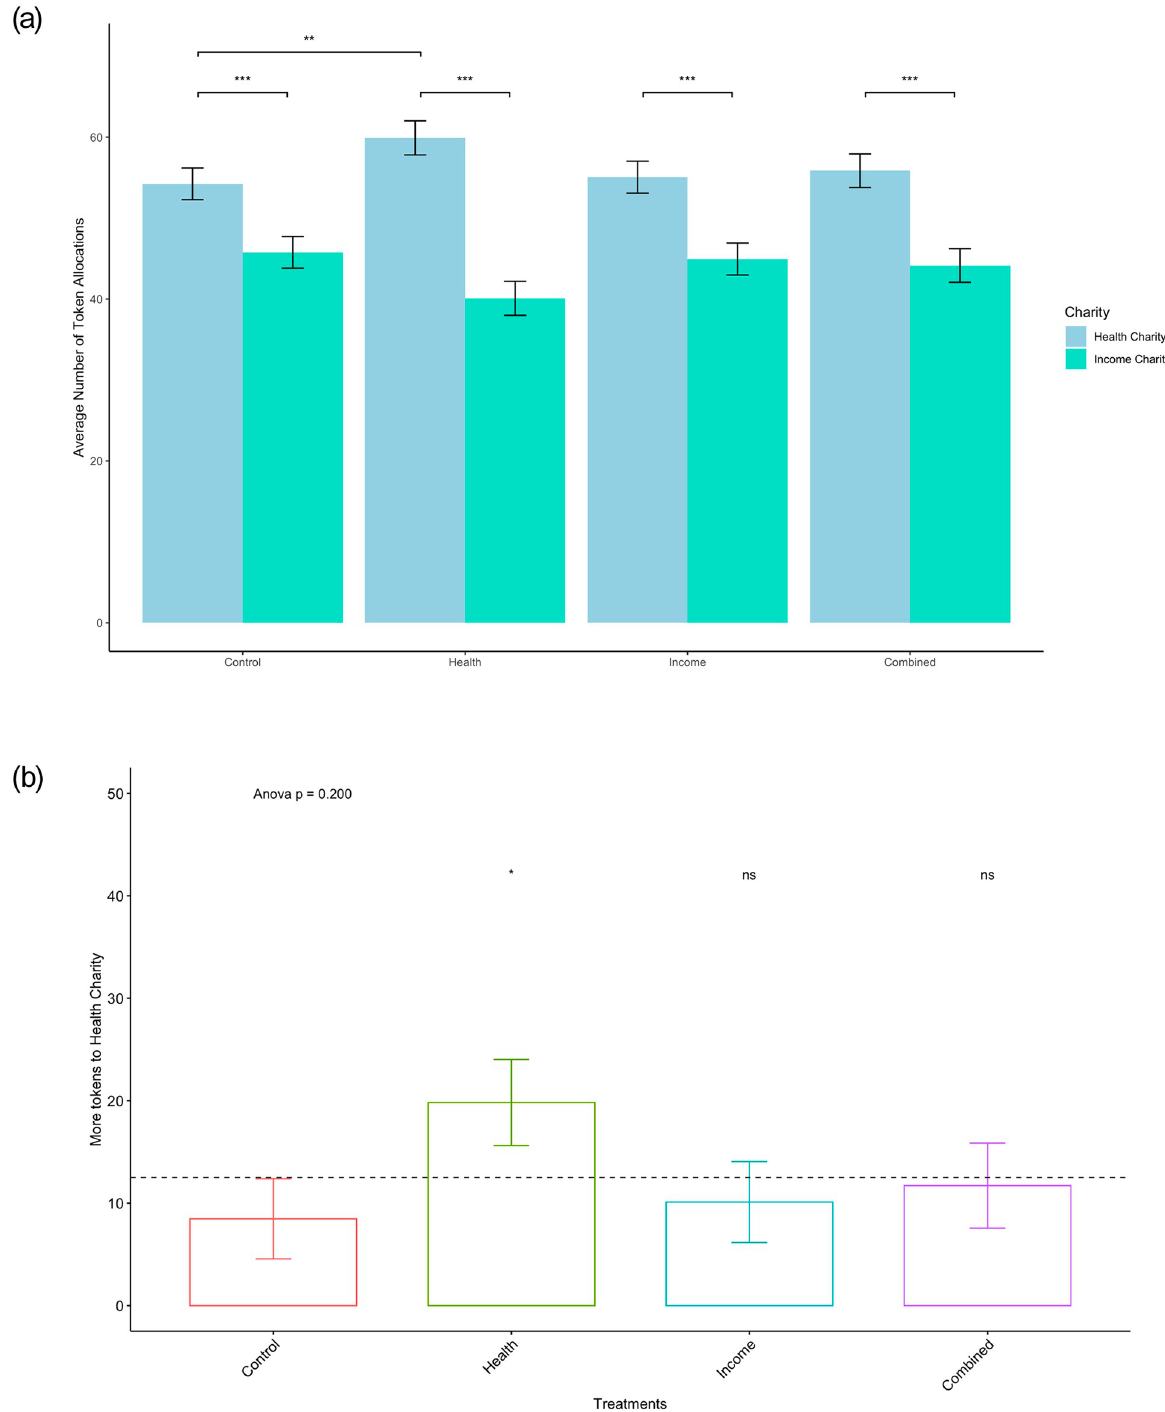
Fig 1. Allocations of tokens between health and income causes. (a) The average number of token allocations for the health and Income causes. (b) The average number of allocated token differences between the Health and Income causes (positive numbers indicate relatively more allocations to the Health Charity ). The dashed line indicate the overall sample mean. Standard errors are shown with whiskers. � p < 0.1, �� p < 0.05, ��� p < 0.01.